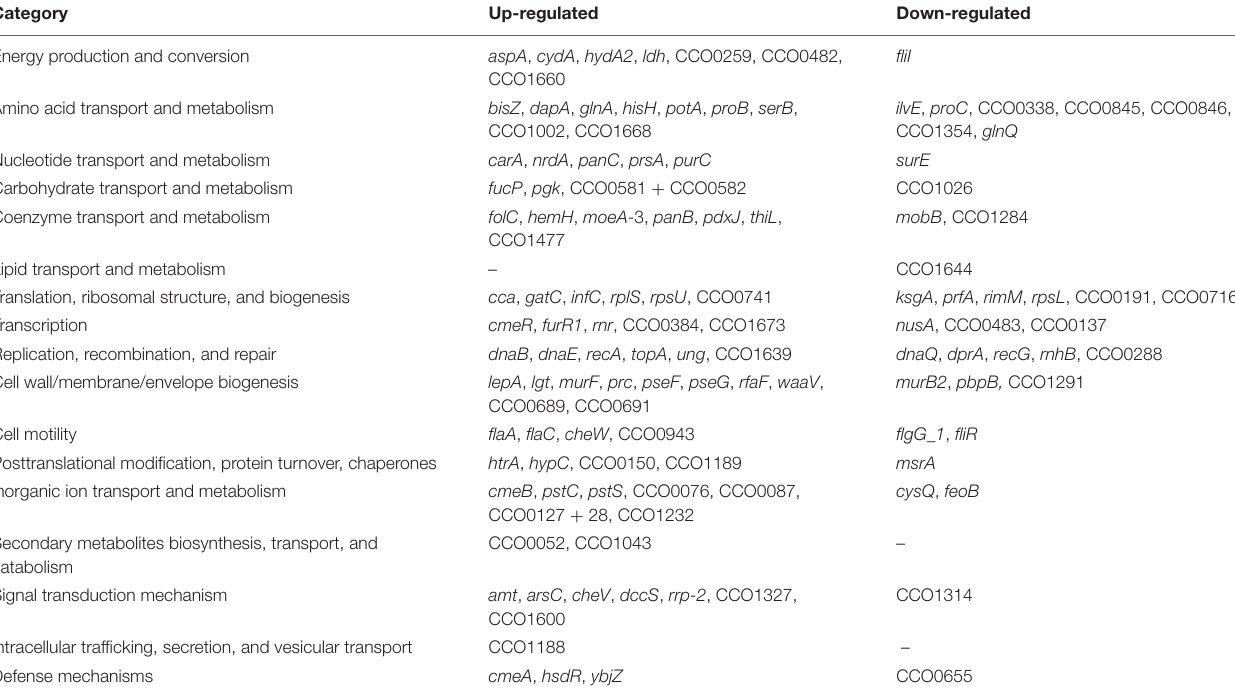
TABLE 3 | Genes differentially regulated after heat stress in C. coli RM2228 only.